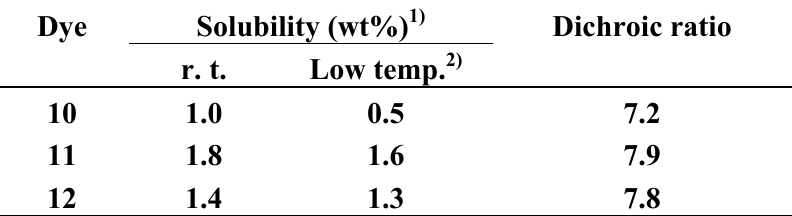
Table 3. The relationships between molecular structures of yellow anthraquinone dyes and their solubilities and dichroic